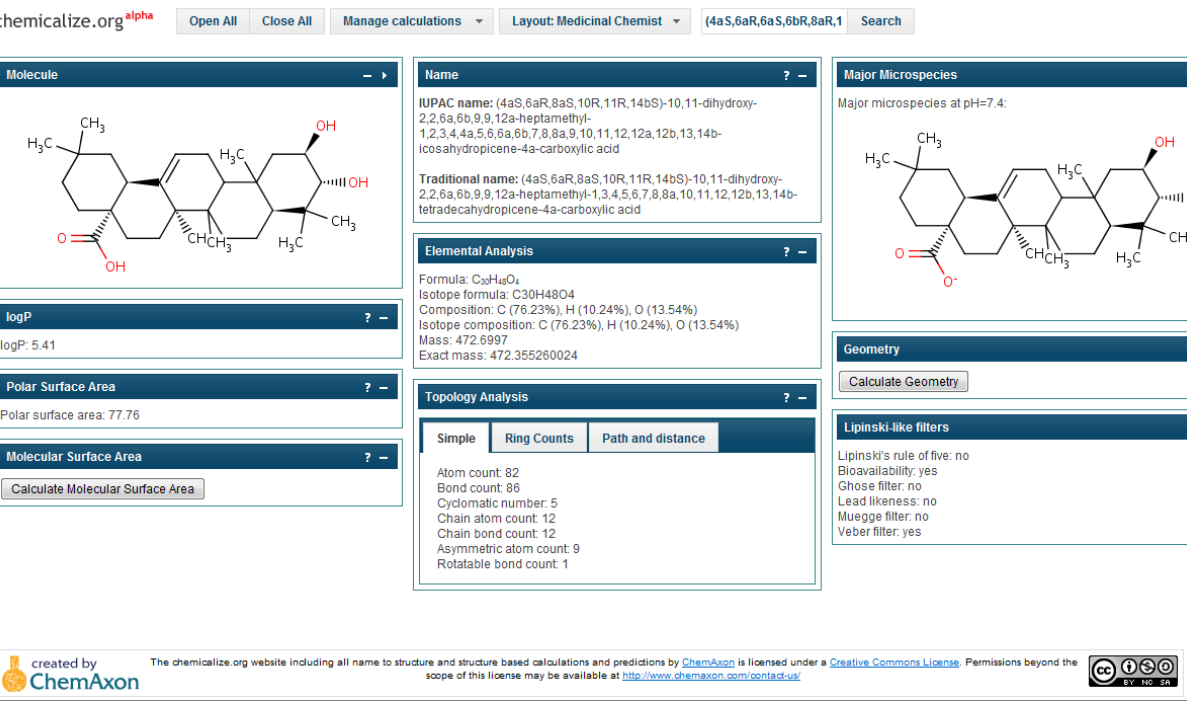
Figure 4. Chemicalize — Link to ChemAxon’s calculations of molecular